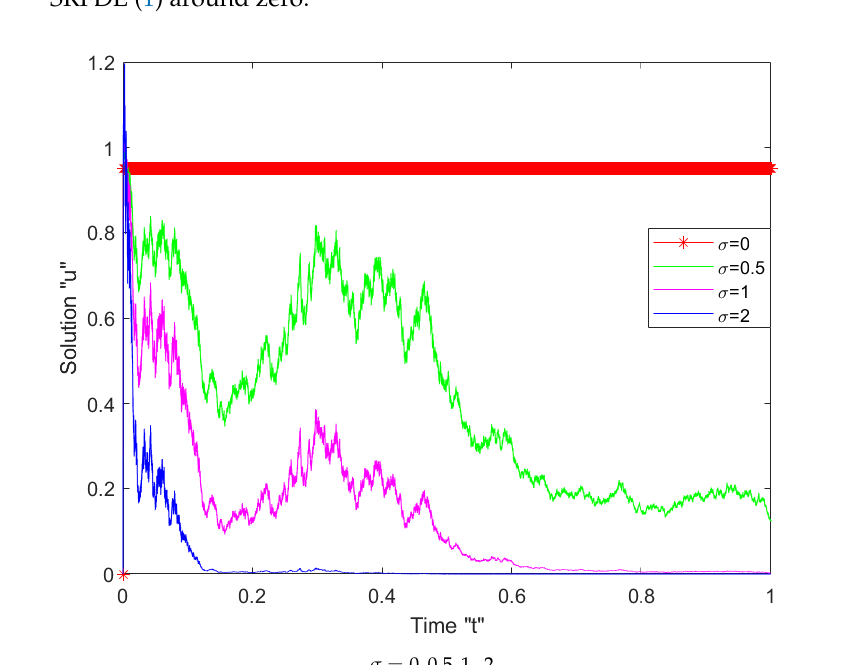
Figure 3. 2D shapes of the solutions (14) with α =